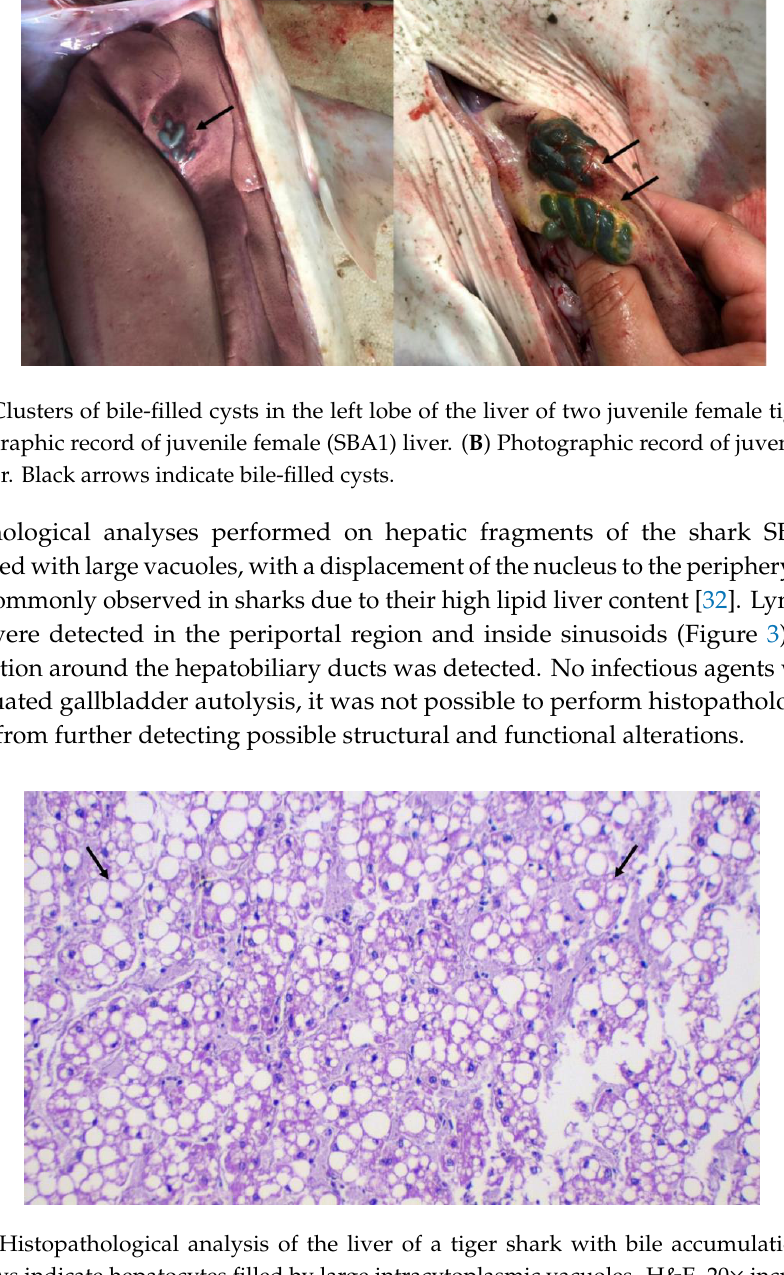
Figure 4. Principal component analysis (PCA) biplot of biomarker concentrations as a function of shark groups (LS—live sharks, DS—dead sharks, SBA—sharks with bile accumulation).